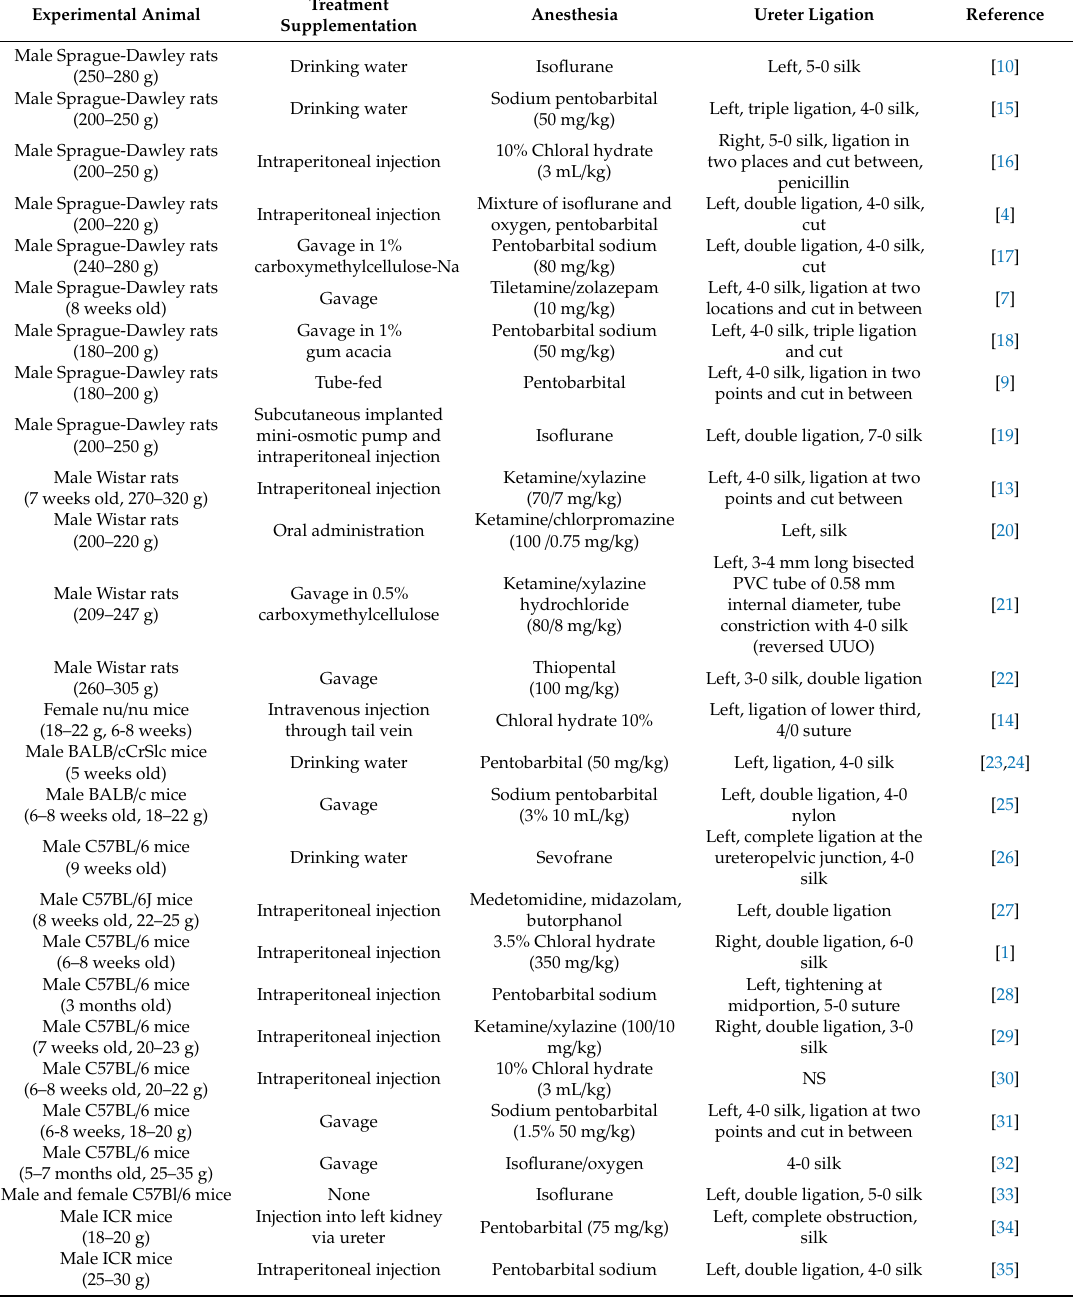
Table 1. Summary of technical details of UUO experiments discussed in this